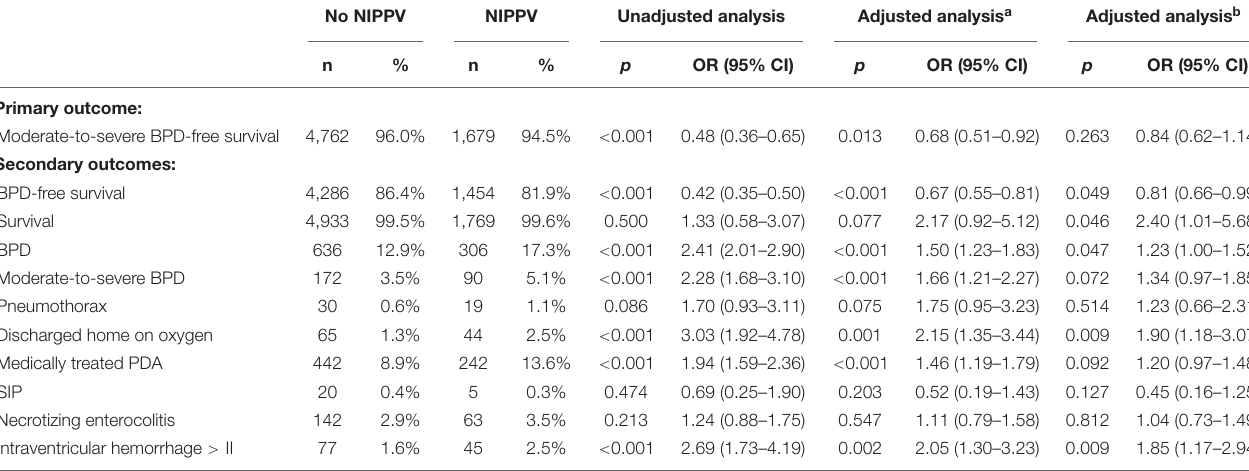
TABLE 2 | Primary and secondary outcomes according to the use of non-invasive positive pressure ventilation (NIPPV). No NIPPV NIPPV Unadjusted analysis Adjusted analysis a Adjusted analysis b